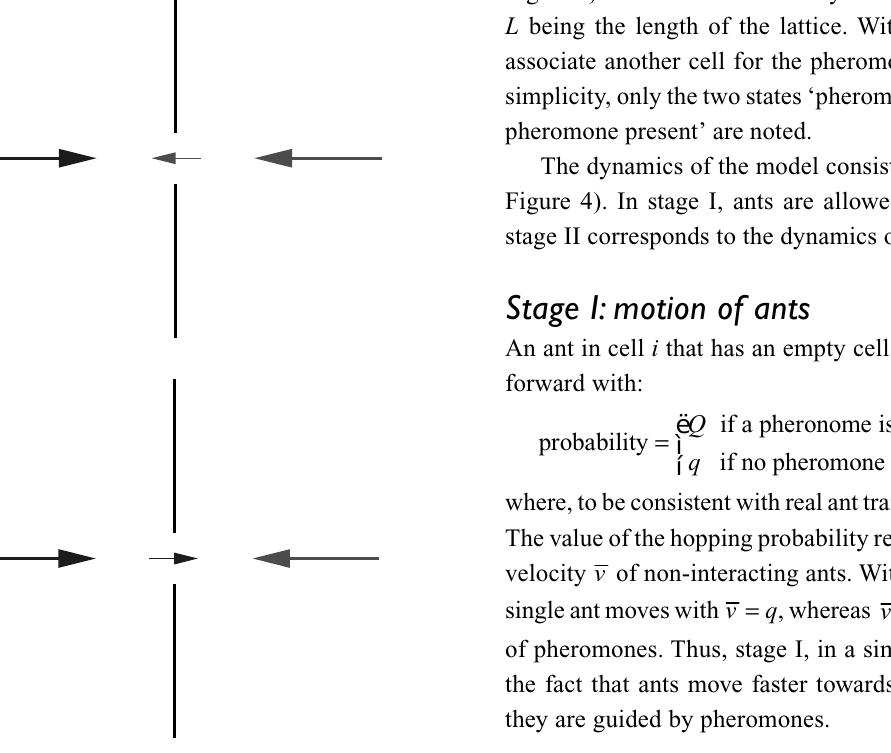
Figure 3 Oscillations of the flow direction at a door with counterflow.